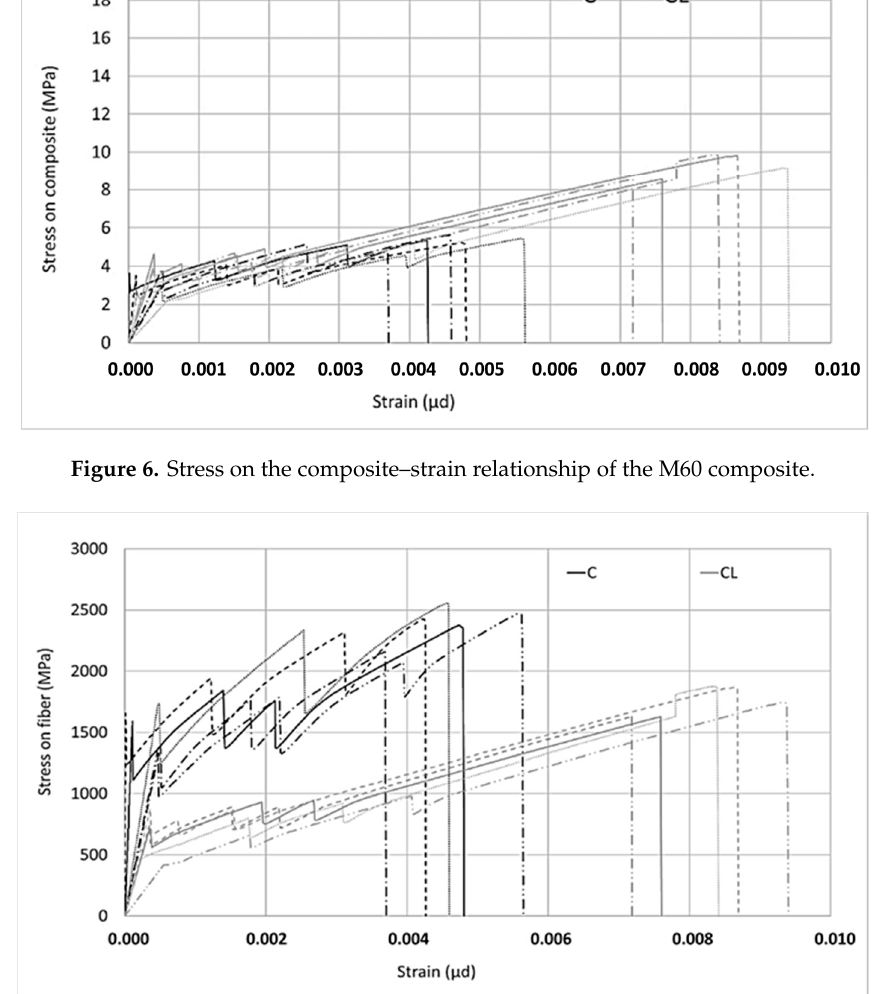
Figure 6. Stress on the composite–strain relationship of the M60 composite.